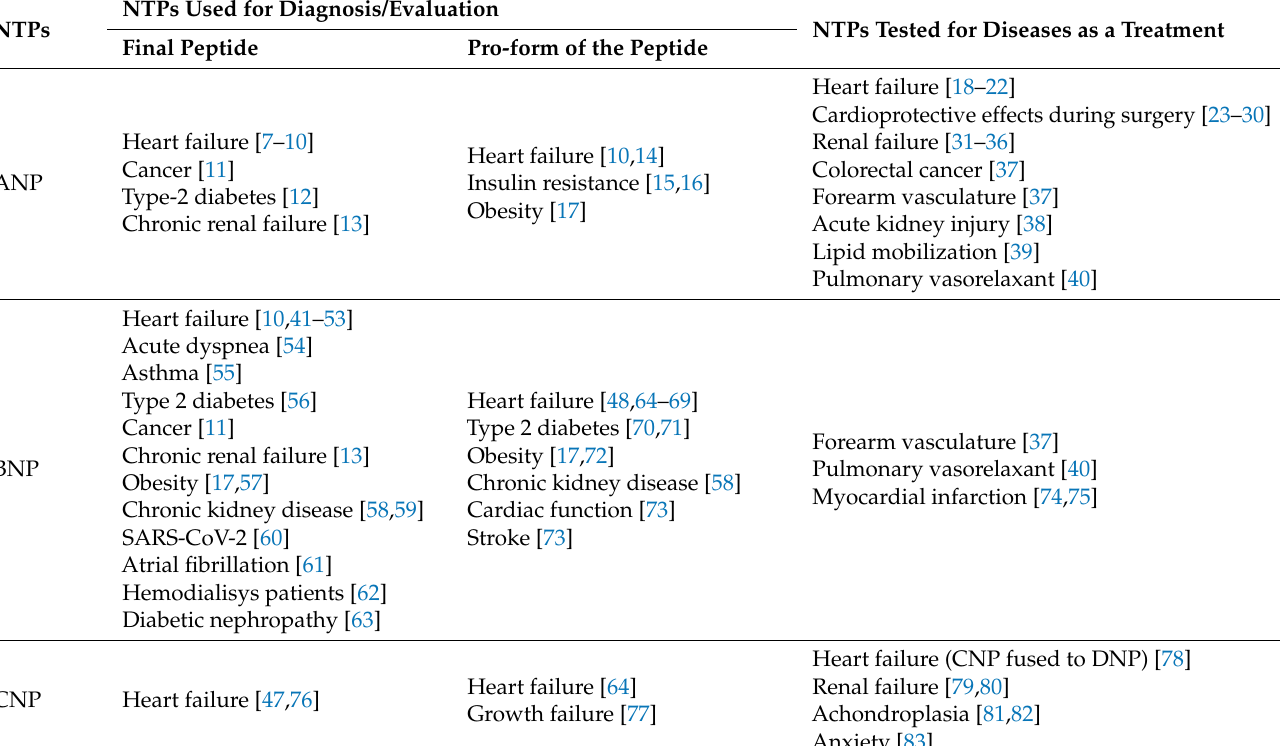
Table 1. Natriuretic peptides used in diagnosis and